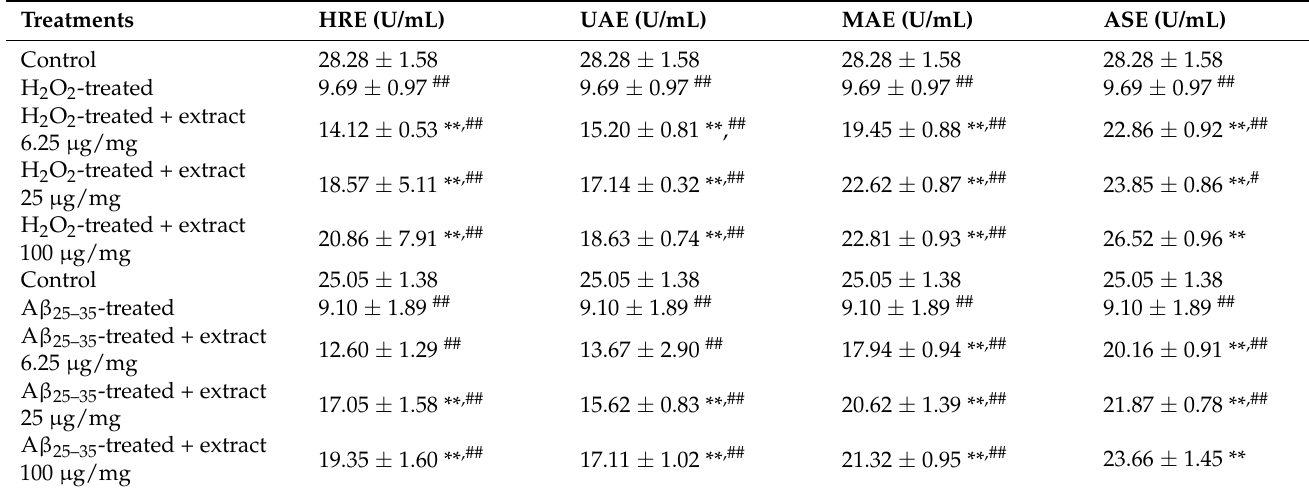
Table 6. Effects of Gardeniae fructus extracts on T-SOD activity of H 2 O 2 - or A β 25–35 -treated PC12 cells (mean ± SD, n = 3). Treatments